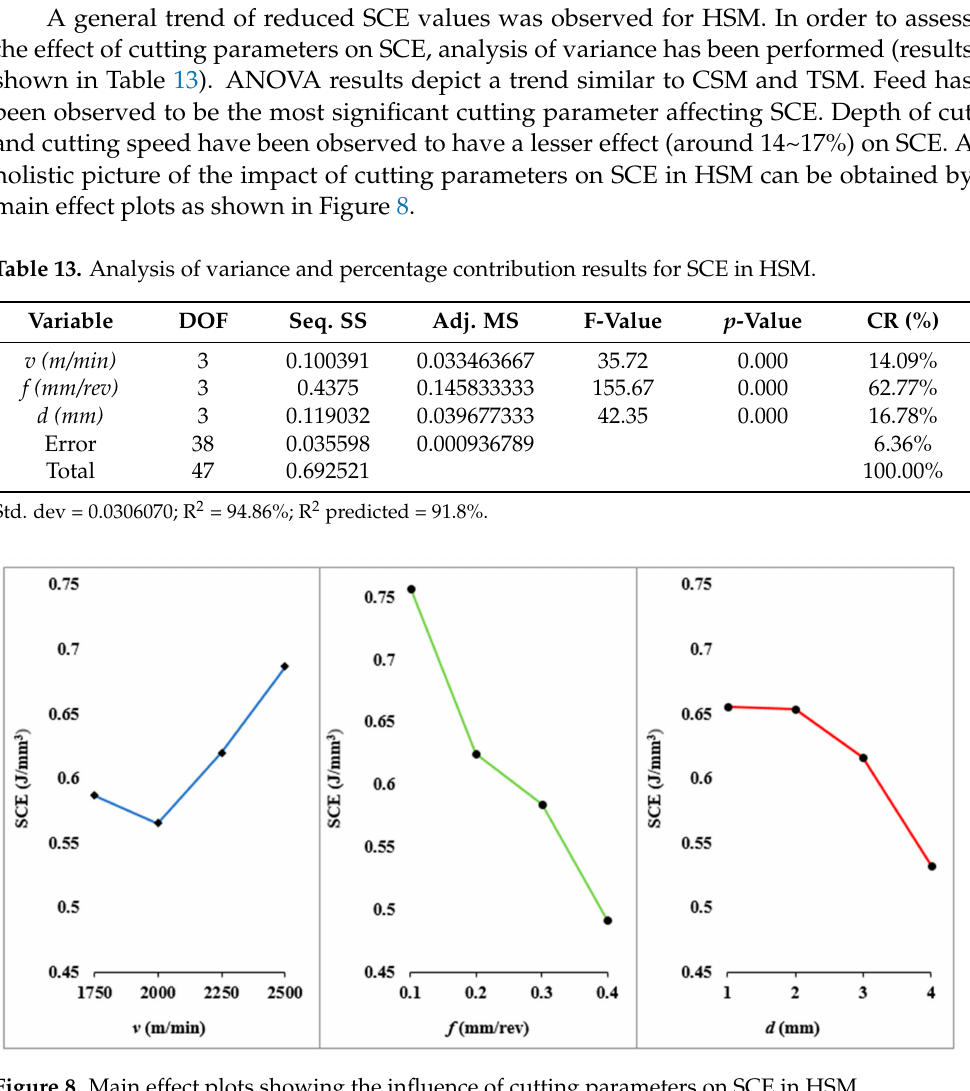
Figure 8. Main effect plots showing the influence of cutting parameters on SCE in